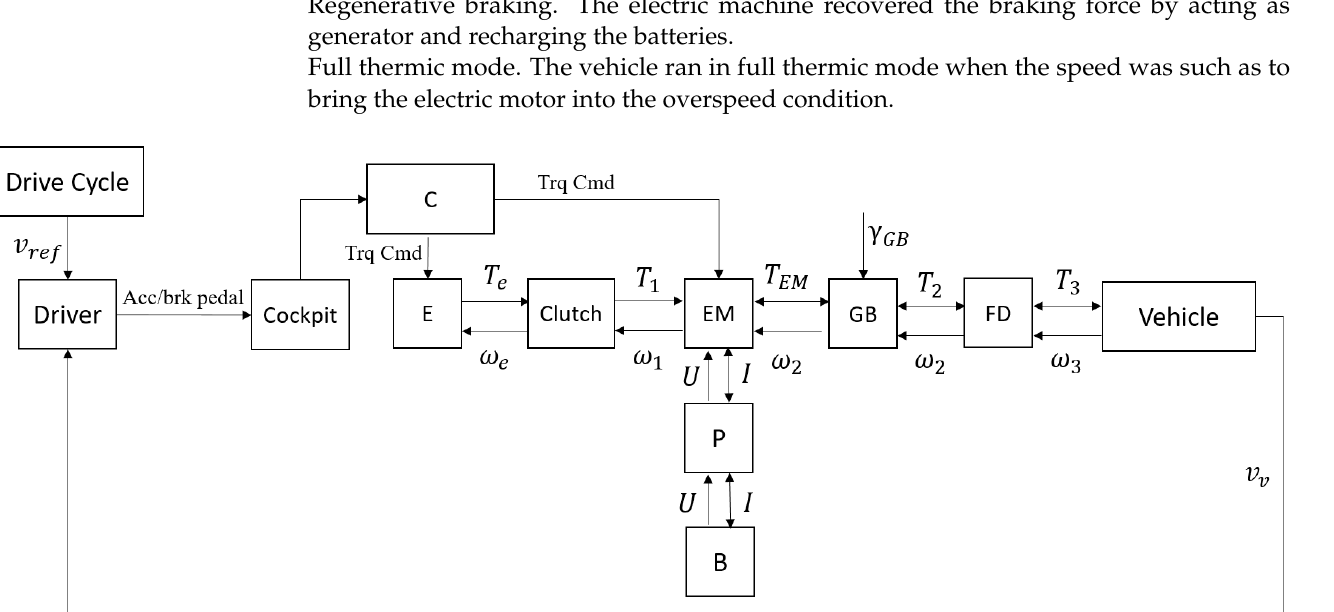
Figure 8. HEV feed-forward model scheme. B: battery, C: control unit E: engine, EM: electric motor/generator, P: power converter, U : voltage, I : current, T : torque, ω : rotational speed, γ GB : gearbox gear ratio v ref : reference speed, v v : vehicle speed.